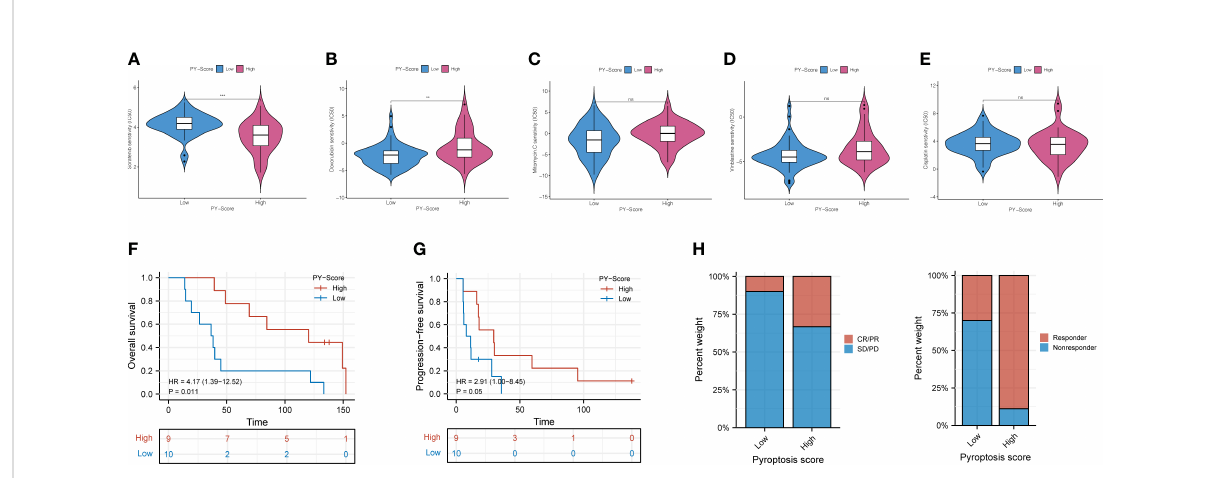
FIGURE 8 The role of PYS in assessing chemotherapy and the bene fi t of anti-PD-L1 immunotherapy. (A – E) HBV-HCC patients in the high-PYS group were associated with a lower IC50 for chemotherapy, such as Sorafenib (A) , while a higher IC 50 was associated with Doxorubicin (B) . Mitomycin C (C) , Vinblastine (D) , and Cisplatin (E) did not show a meaningful difference. (F, G) Overall survival (F) and progression-free survival (G) curves of patients within high- and low-PYS groups in the GSE140901 cohort. (H) Clinical response to anti-PD-L1 immunotherapy between PYS groups. CR, complete response; PR, partial response; SD, stable disease; PD, progressive disease; PFS, progression-free survival; PYS, pyroptosis score. **P < 0.01; ***P < 0.001; ns, not statistically signi fi cant.